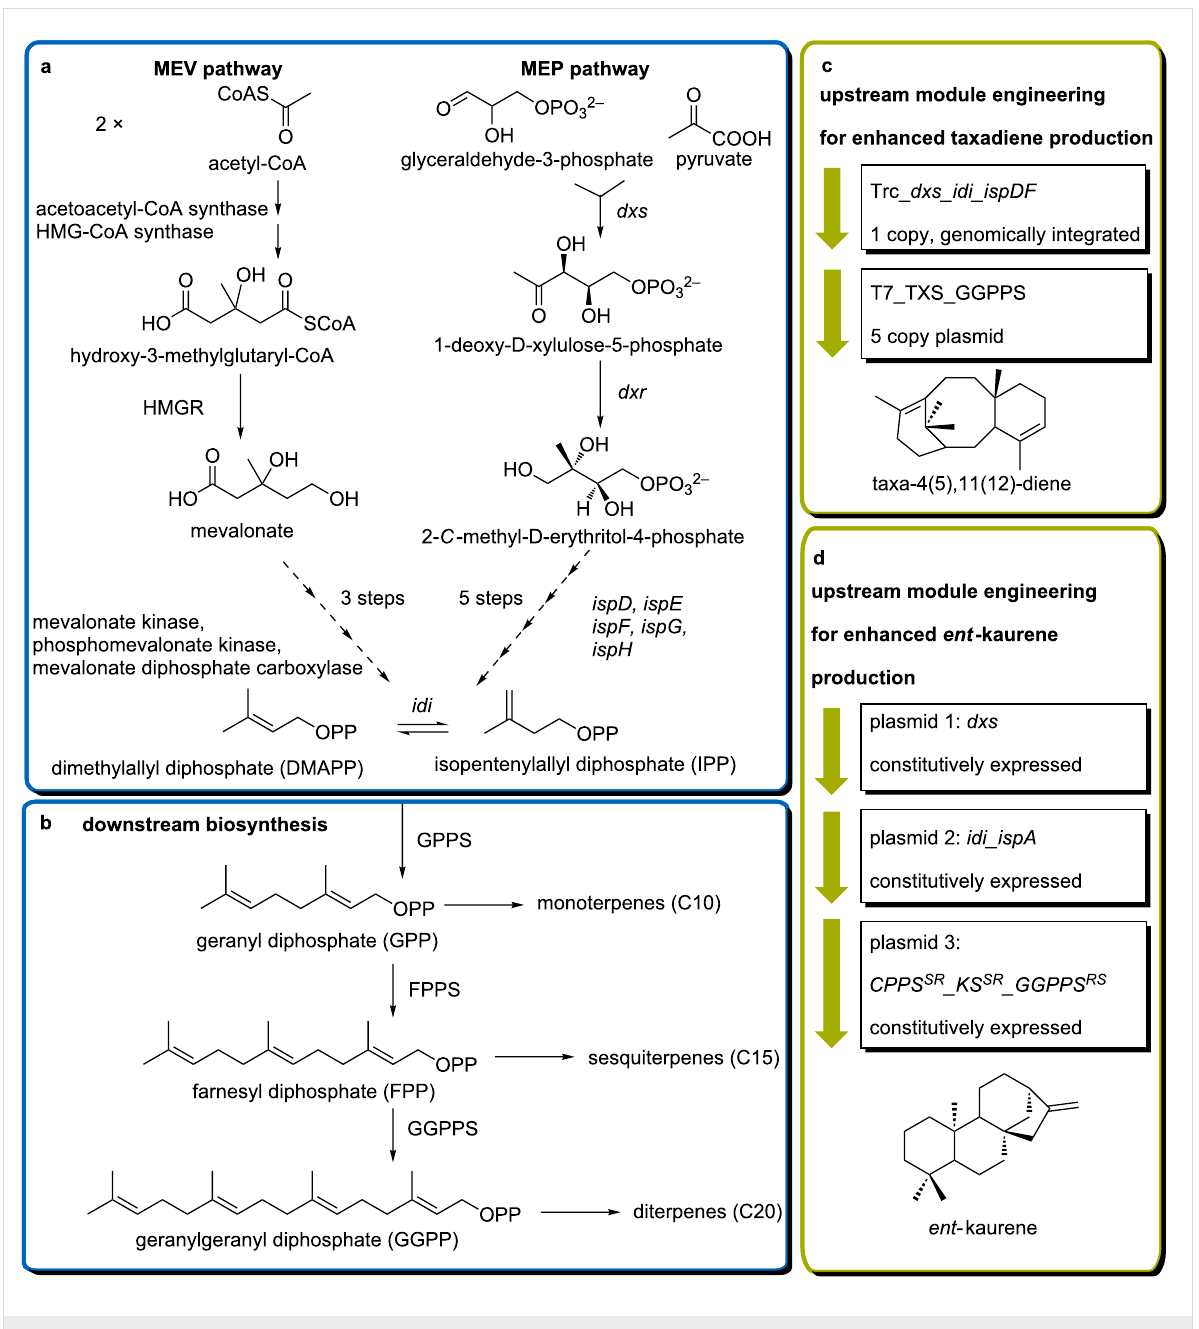
Scheme 1: Isoprenoid biosynthetic pathways and examples for their engineering in heterologous production systems. a) Formation of central isoprenoid metabolites isopentenyl diphosphate (IPP) and dimethylallyl diphosphate (DMAPP) occurs via two distinct natural pathways. Designations MEV and MEP derive from significant intermediates: MEV = mevalonate-dependent and MEP= methylerythritol phosphate-dependent. b) Subsequent condensation of IPP and DMAPP by isoprenyl diphosphate synthases provides specific terpene synthases with their linear substrates. Terpenes are classified according to the carbon atom number in their basic scaffold, beginning with hemiterpenes (C5) and continuing in multiples of five. c) A possible strategy for MEP-pathway optimization for the improved production of the diterpene taxadiene reported by Ajikumar et al. [28]; targeted elements of the biosynthetic pathways and their expression manipulations are given. d) Selection of overexpression targets for the production of ent - kaurene reported by Kong et al. [29]; HMGR = hydroxymethylglutaryl(HMG)-CoA-reductase; dxs = 1-deoxy-D-xylulose-5-phosphate